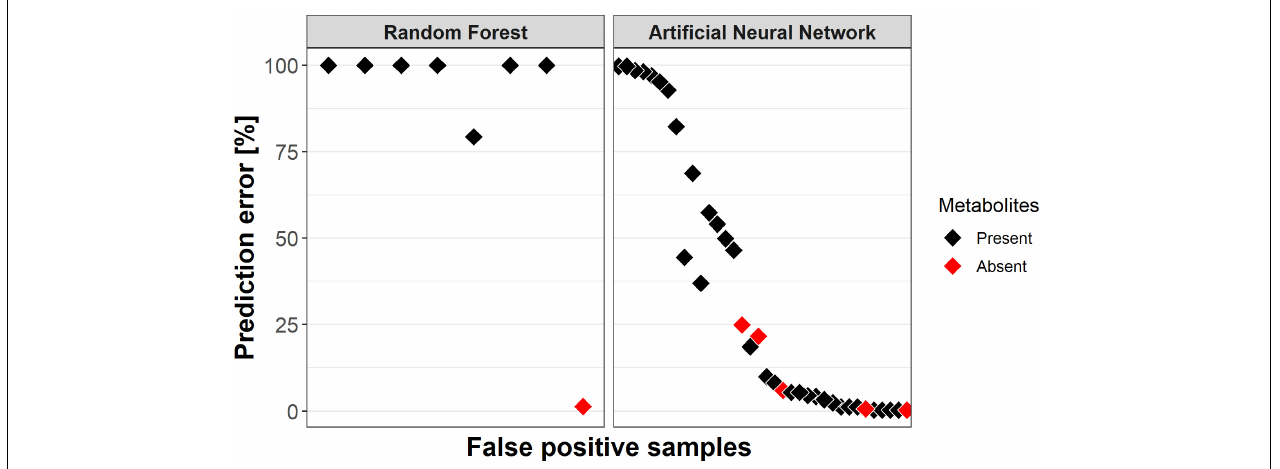
FIGURE 6 | Misclassification rates of samples which were predicted “TNT present” but did not contain the explosive (False positive prediction). Red indicates whether a false positive samples contained TNT metabolites, i.e., ADNTs and DANTs. Samples containing metabolites were more likely to be misclassified as false